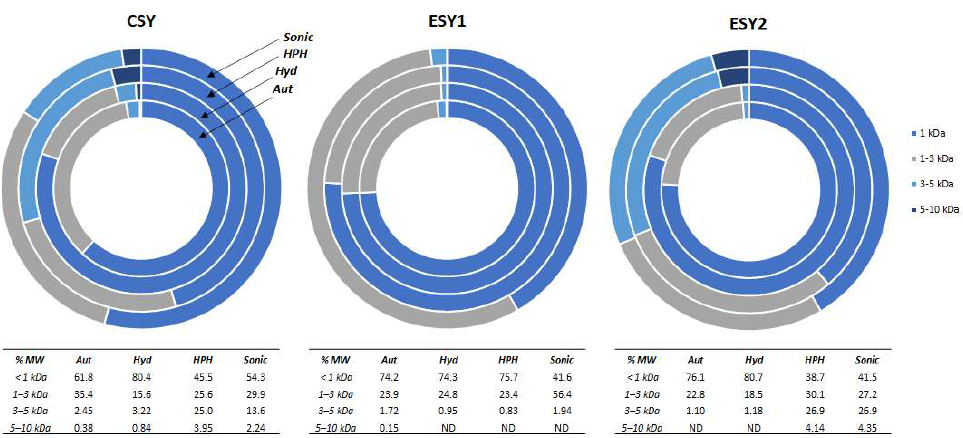
Figure 1. Peptides molecular weight distribution (% MW) in peptide-rich extracts obtained from each extraction process (Aut—autolysis, Hyd—enzymatic hydrolysis, HPH—high pressure homog- enization, Sonic—sonication) applied to the different yeast strains (CSY, ESY1 and ESY2). ND—not detected (below low detection limit).